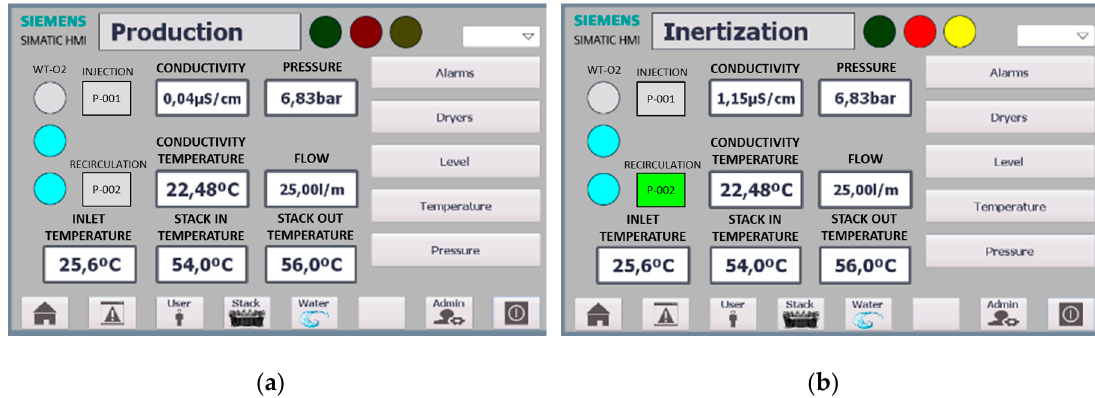
Figure 13. Water management subsystem monitoring interface: ( a ) physic-chemical parameters; ( b ) alarm by high conductivity.